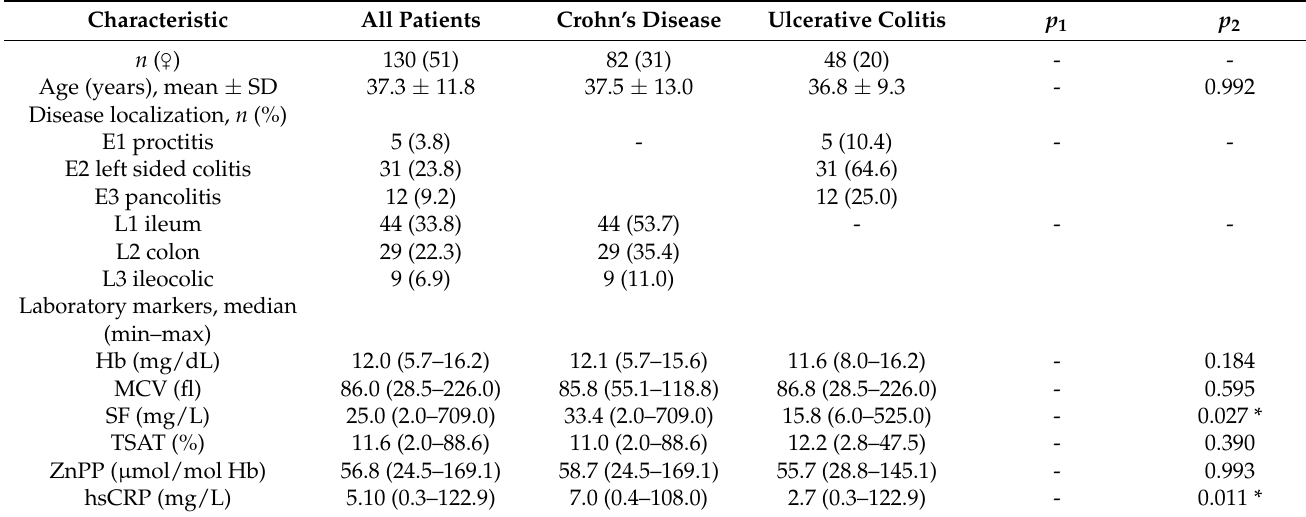
Table 1. Baseline patient characteristics.